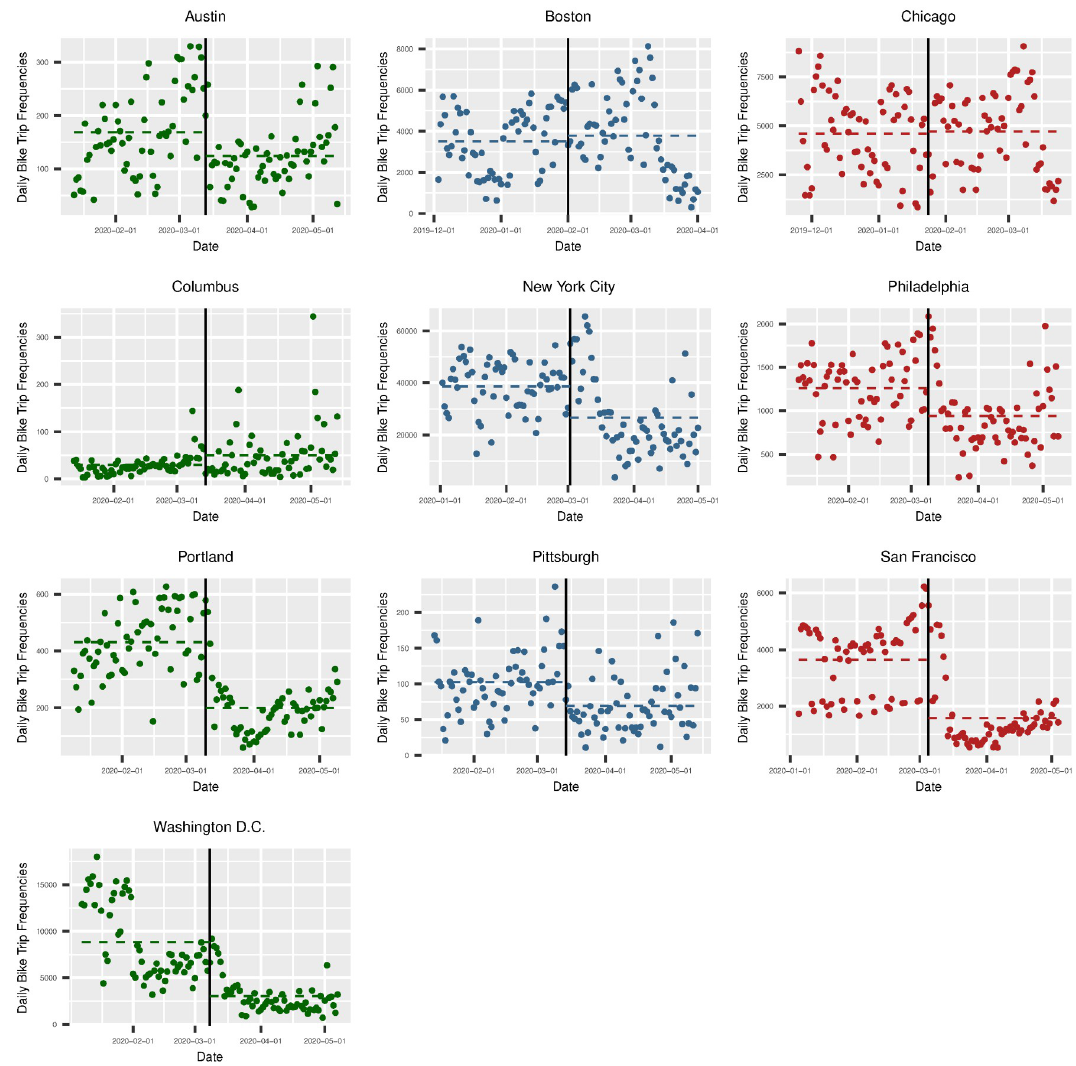
Fig 1. Frequency of bike-sharing platform trips over time, before and after the first Covid-19